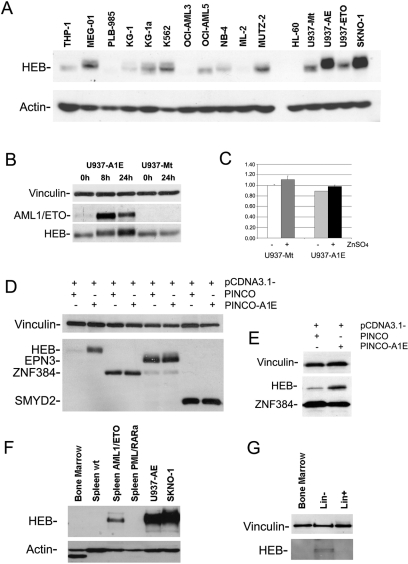
HEB protein levels increase in AML1/ETO-expressing cells.(A) Expression of HEB protein in a panel of human myeloid cell lines: 30 µg of total cell lysates were analyzed by Western blot with an anti-HEB antibody. AML1/ETO positive cells (U937-AE and SKNO-1) express higher levels of HEB. U937 cell lines were induced with ZnSO4 for 24 hours. An anti-actin antibody was used for normalization of protein levels. (B) U937-AE cells were treated for 8 and 24 hours with 100 µM ZnSO4. AML1/ETO protein levels peak after 8 hours. HEB protein levels increase after AML1/ETO expression. No modification in HEB levels is detectable after ZnSO4induction of control U937-Mt cells. (C) HEB mRNA levels in U937-AE and U937-Mt cells prior to and after 8 hours of 100 µM ZnSO4 treatment are shown (GAPDH normalized). AML1/ETO does not modify the levels of HEB transcript. (D) HEB protein levels in HeLa cells increase when pCDNA3.1-FLAG-HEB is co-transfected with PINCO-AML1/ETO expression vector. This effect is not seen after co-transfection of AML1/ETO with other genes cloned into the same vector (pCDNA3.1-FLAG). All proteins were revealed by anti-FLAG immunoblot. (E) Co-transfection of PINCO-AML1/ETO with both pCDNA3.1-FLAG-HEB and pCDNA3.1-FLAG-ZNF384 results in a specific increase of HEB protein levels. (F) Expression of HEB protein in mouse tissues. HEB is not detected in wild-type murine bone marrow or spleen. AML blasts derived from the spleens of AML1/ETO transgenic mice express HEB, whereas blasts from PML/RARα transgenics do not. (G) HEB protein levels were analyzed in total bone marrow, Lin− and Lin+ cellular compartments form wild-type mice. Detectable levels of HEB are found only in the Lin− fraction of murine bone marrow.